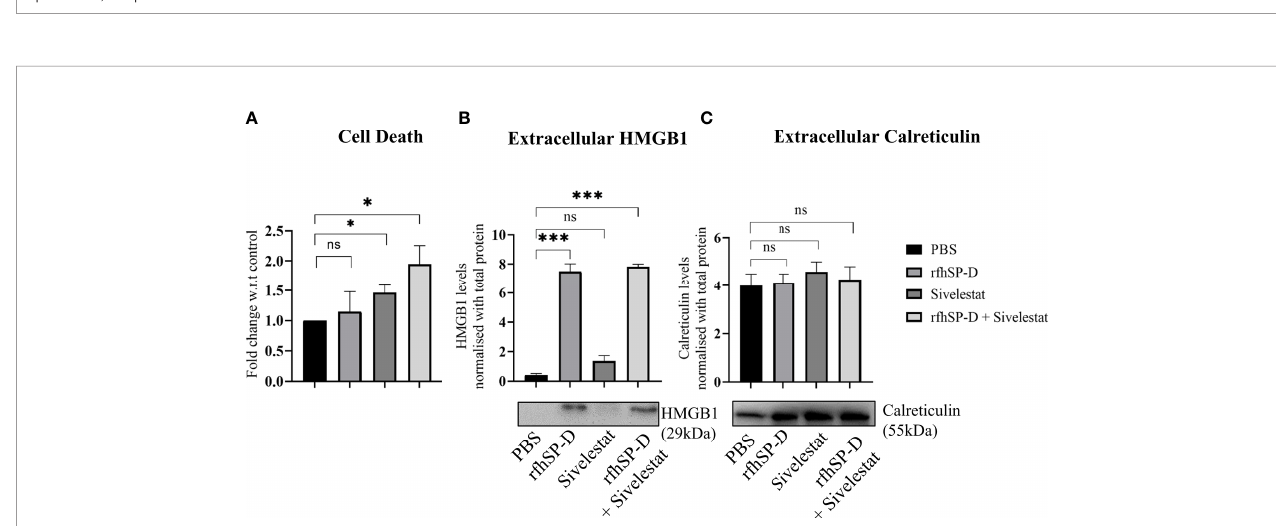
FIGURE 8 | Assessment of cell death and released ICD markers in ex vivo cultured TRAMP tumours. Tumour tissues were collected from the late TRAMP and cultured in serum-free DMEM with PBS, rfhSP-D, sivelestat and rfhSP-D+sivelestat treatment for 72h. (A) After treatment, single cell suspensions were prepared and percentage of Propidium Iodide-positive (PI + ) (dead) cells were analysed by fl ow cytometry. (B, C) After treatment, the culture-media were subjected to western blot. (B) Representative immunoblot and densitometric analysis of extracellular HMGB1. (C) Representative immunoblot and densitometric analysis of extracellular calreticulin. n=3/treatment group. Data represented as mean ± SEM. Statistical signi fi cance was determined by one-way ANOVA (A) , two-tailed Student ’ s t-test (B, C) . ns, Non-signi fi cant. *p < 0.05, ***p <